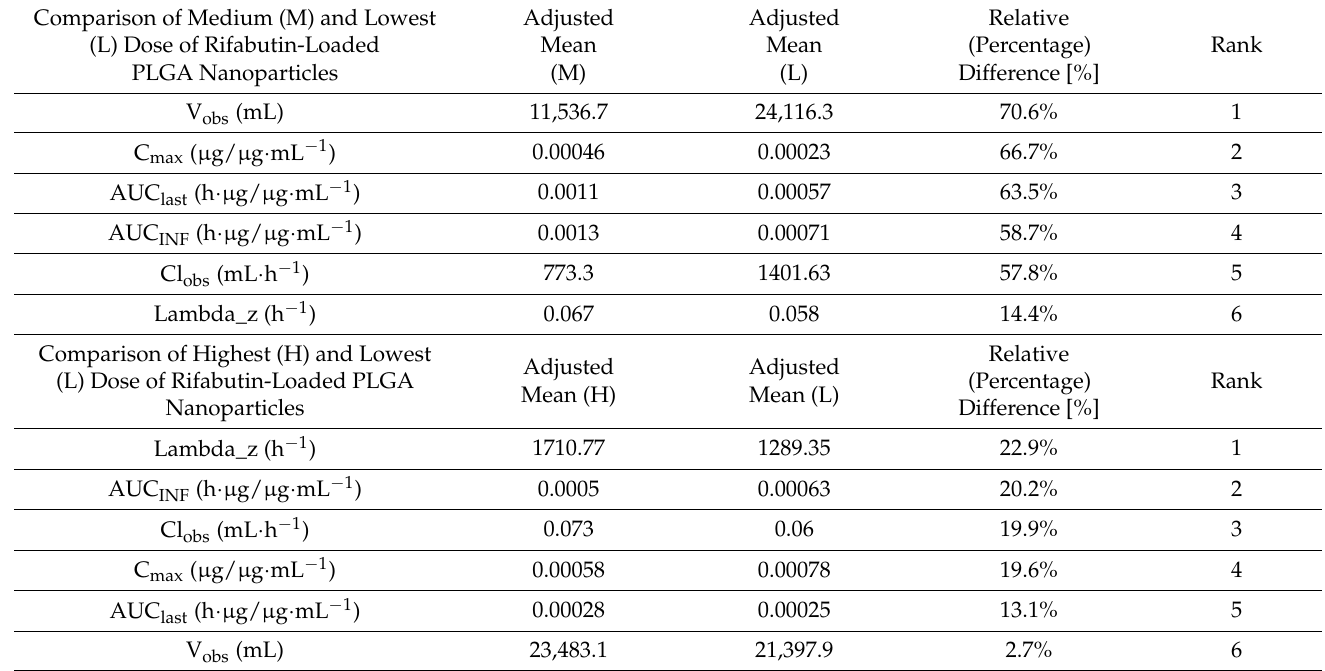
Table 3. NCA evaluation of the pharmacokinetics of rifabutin-loaded PLGA nanoparticles in rabbits ( n = 5) using the PKanalix bioequivalence module. The different dose strengths were compared based on the dose fractions per milliliter and all parameters were calculated accordingly.